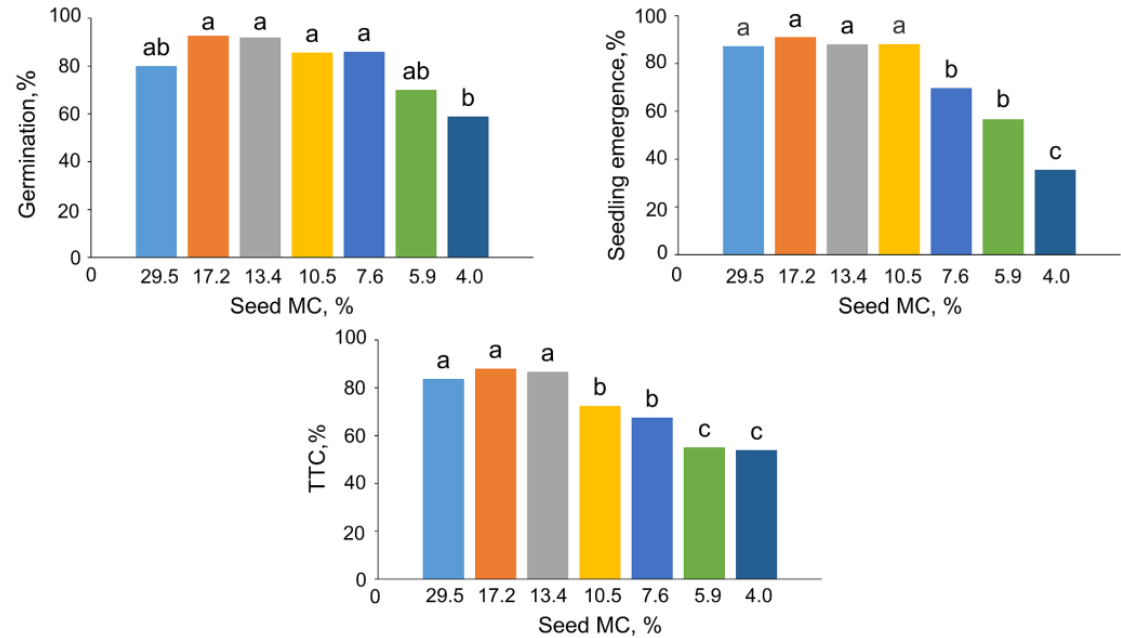
Figure 1. Effect of seed moisture content (MC) on the germination, seedling emergence, and respiratory activity (TTC assay) of Fagus sylvatica L. seeds. Values labeled with different letters are significantly different at p ≤ 0.05, analysis of variance (ANOVA), Tukey test. Data represent the mean ± se ( n = 5).